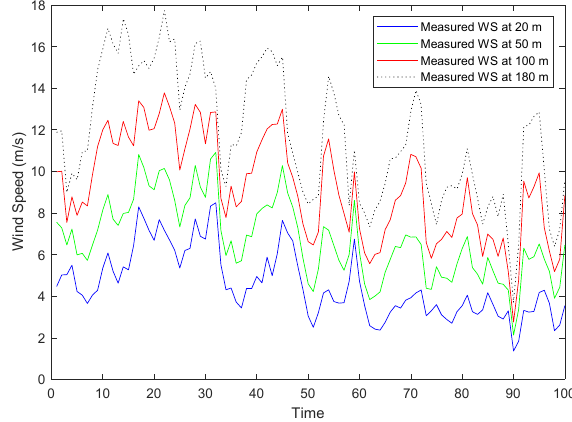
Figure 1. Samples of measured WS at various heights